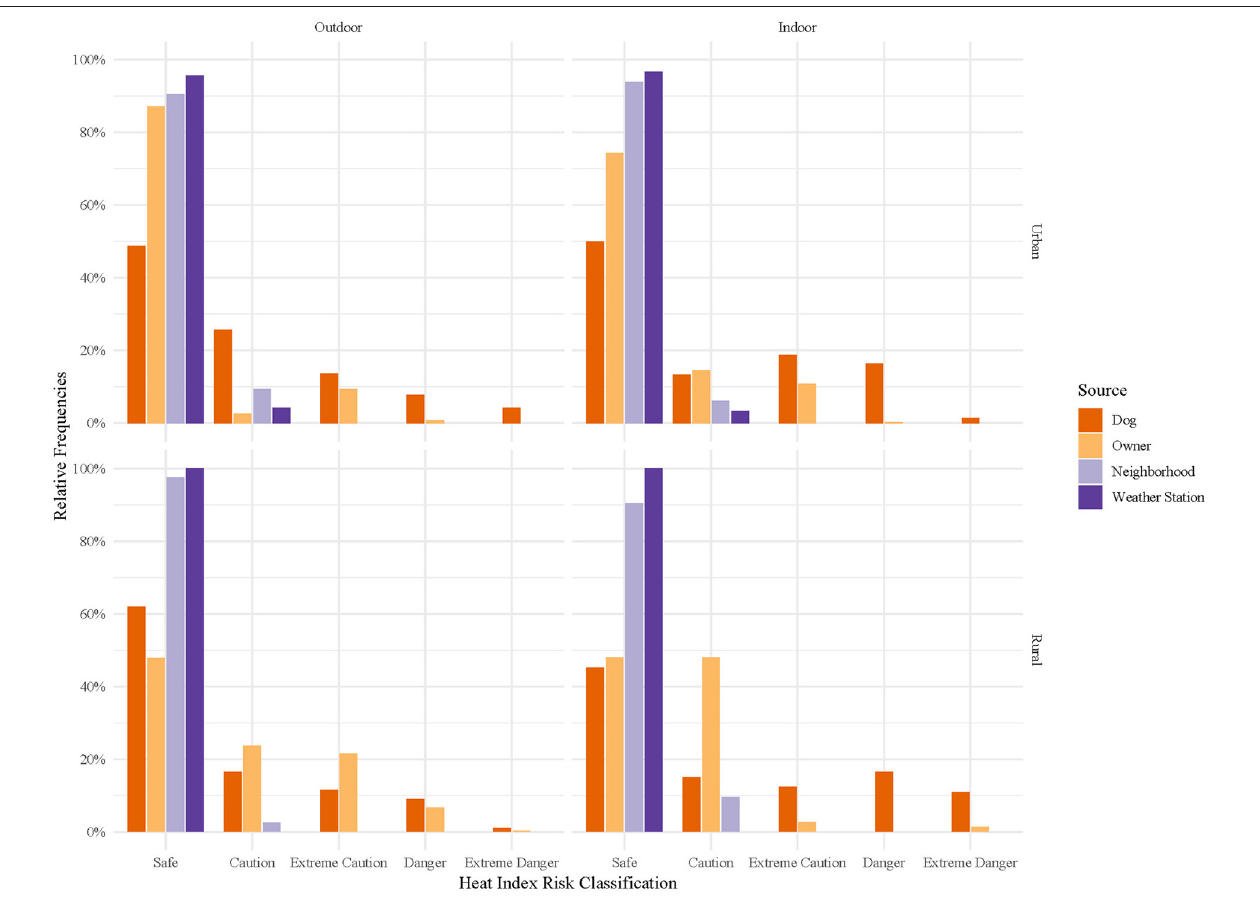
FIGURE 8 | Relative frequencies of hourly heat index risk classification during nightime hours as calculated for canine pets’ thermometers, owners’ thermometers, neighborhood weather stations, and nearest weather station, stratified by home environment (outdoor or indoor) and location (urban or rural). Nightime hours were 12 AM to 5 AM. Heat index risk classifications were determined by the National Weather Service’s designations: Safe ( < 80 ◦ F), Caution (80–90 ◦ F), Extreme Caution (90–103 ◦ F), Danger (103–124 ◦ F), and Extreme Danger ( ≥ 125 ◦ F) (35).